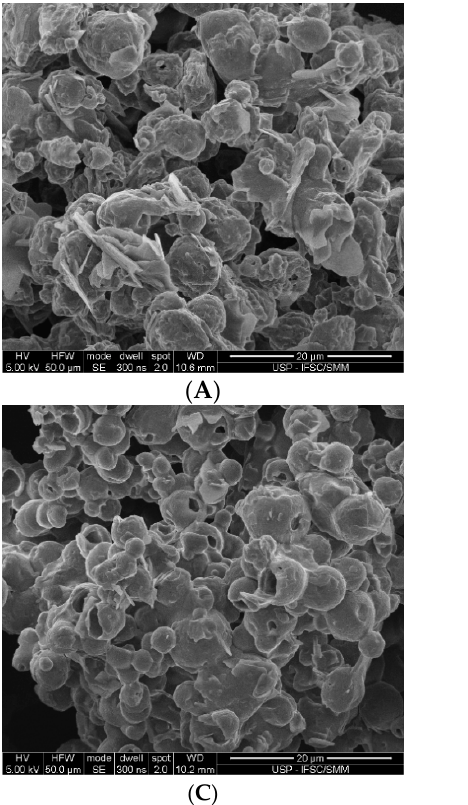
Figure 4. Particle morphology of spray-dried lipid carriers: PLR1 ( A ), PLR2 ( B ), PLR3 ( C ) and PLR4 ( D